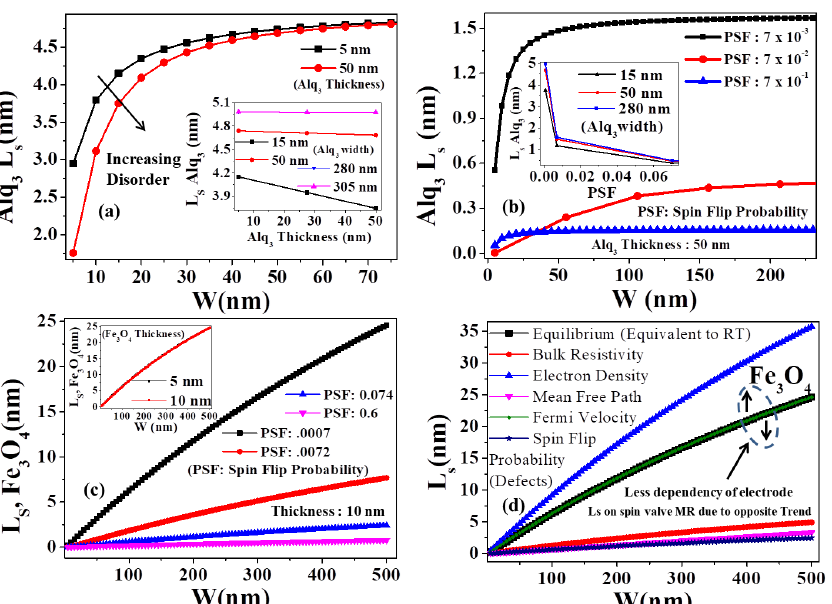
Figure 2. ( a ) Spin Relaxation Length (L S ) variation with Film width (W), at 5 and 50 nm thicknesses, for Organic Semiconductor Alq 3 considering coherent Spin injection and extraction. Inset shows the variation of L S with Alq 3 thickness at different Alq 3 width ( b ) Variation of L S with Alq 3 width at different defect states induced spin-flip probabilities (PSF). Inset shows the variation of L S with different PSF at different Alq 3 width ( c ) Variation of L S with Fe 3 O 4 width at different Fe 3 O 4 defect states induced spin-flip probability (PSF). Inset shows Spin Relaxation Length (L S ) variation with Film width (W), at 5 and 10 nm thicknesses, for Fe 3 O 4 ( d ) Variation of L S with Fe 3 O 4 width for different deviated (from equilibrium values of Table 1) spin dependent transport parameters. A single profile indicates L S change due to deviation of only that corresponding parameter. The other parameter values are fixed with values from Table